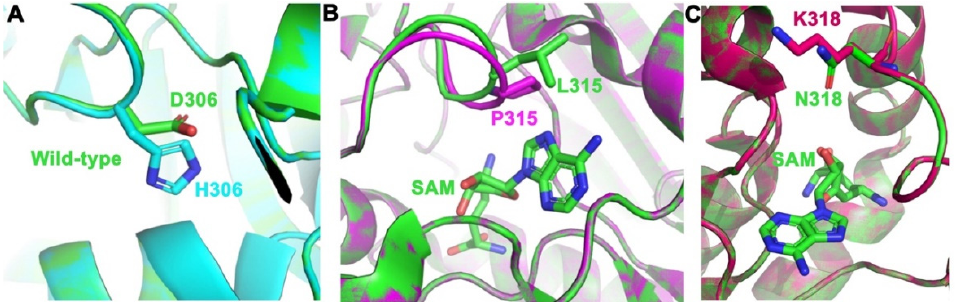
Figure 4. PRMT5 mutations were placed in their respective binding pockets. ( A ) Mutation of D306H (green to cyan) in the substrate-binding pocket. ( B ) Mutation of L315P (green to magenta) in a SAM binding pocket with SAM bound (green sticks). ( C ) Mutation of N318K (green to red) in a SAM binding pocket with SAM bound (green sticks). Figure was made by aligning the wild-type structure (green) of PRMT5 (PDB ID: 4GQB) [36] to the mutant structures using PyMOL.